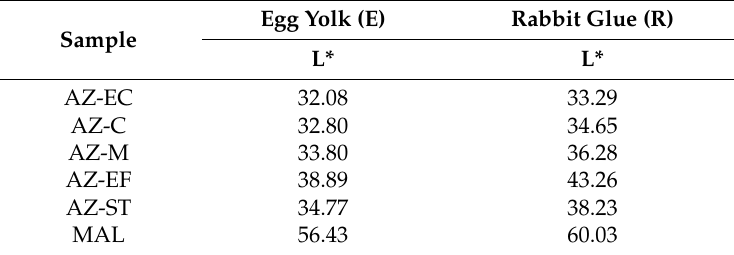
Table 2. L* CIELAB parameter of reference (fresh) paint mock-ups made with azurite (AZ) or malachite (MAL) mixed with either egg yolk (E) or rabbit glue (R).